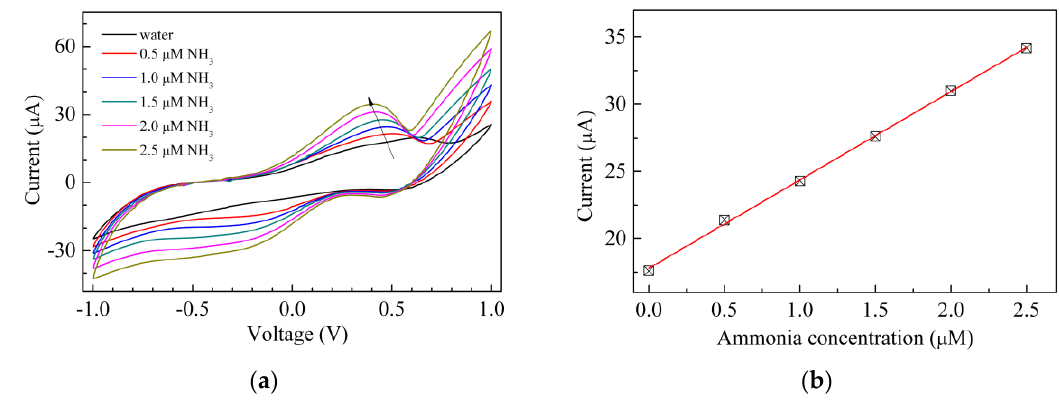
Figure 8. ( a ) Current-voltage loop of the Au/chitosan:CuOx/chitosan/Au cell, measured in pure water, and in the presence of ammonia at different concentrations; ( b ) Intensity of the forward current peak intensities of Figure (a), plotted against the NH 3 concentration.